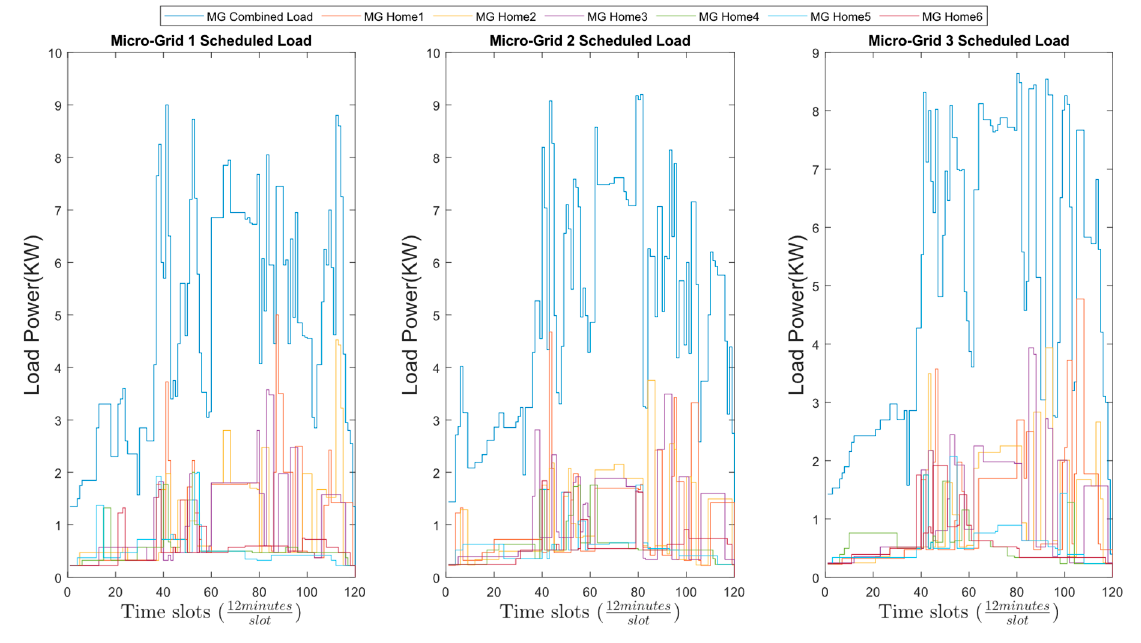
Figure 18. Scheduled load curve of MG 1 , MG 2 , and MG 3 with individual home using MJLBO.